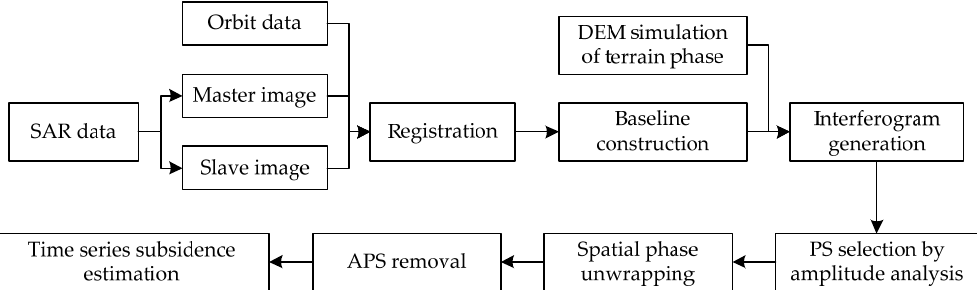
Figure 2. The flowchart for